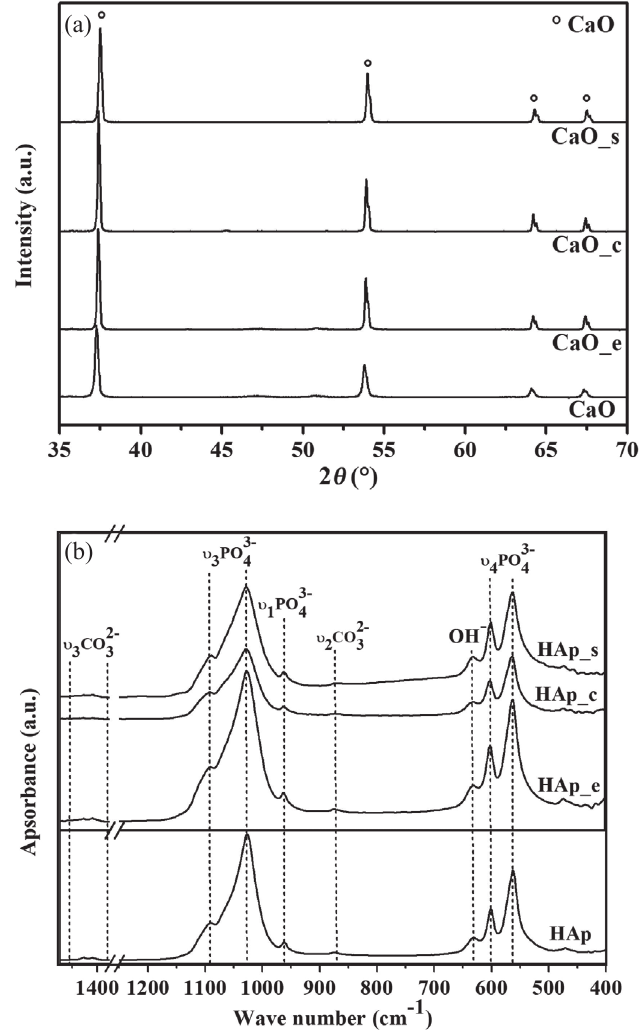
Fig. 2 – XRD patterns (a) of heat-treated calcite (synthetic, CaO; eggshell, CaO_e; cuttlefish bone, CaO_e; seashell, CaO_s). Characteristic CaO (ICDD 82-1691) diffraction max- ima are depicted as (°). FTIR spectra (b) of as-prepared HAp synthesised from prepared calcium